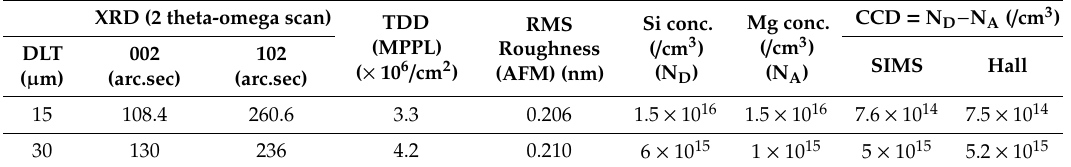
Table 4. Material properties of MOCVD grown GaN drift layers (DL)s such as 2 theta-omega scan, root mean square (RMS) surface roughness, TDD, elemental concentrations and charge carrier density (CCD) measured by SIMS (Si limit 1.0 × 10 14 and Mg limit 2.0 × 10 14 ) and Hall.